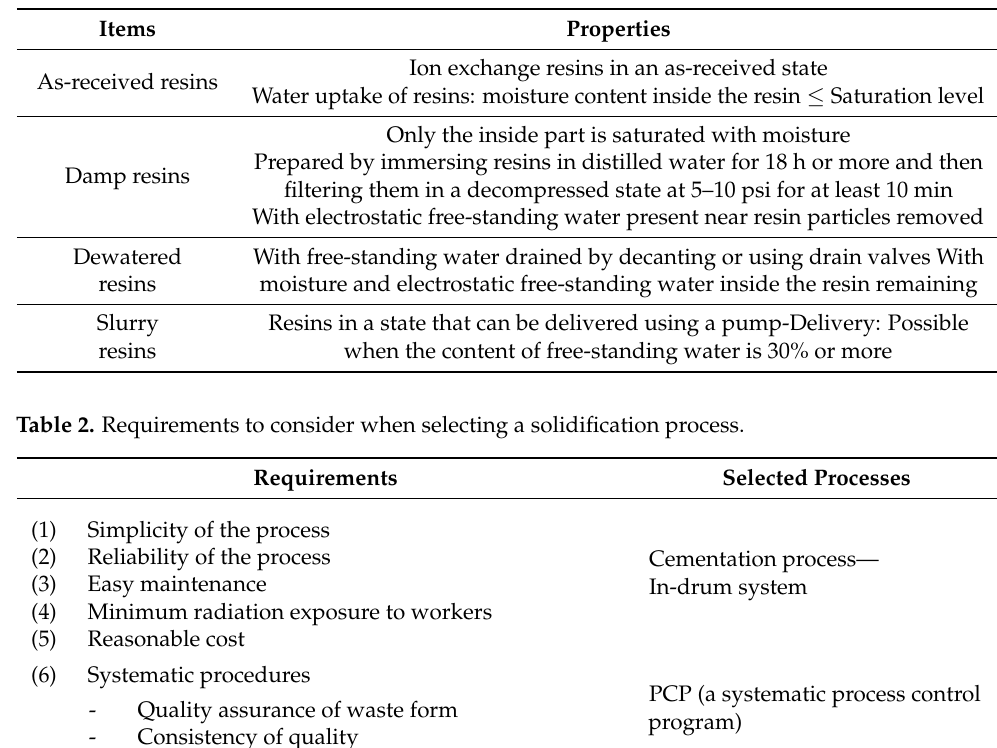
Table 1. Classification of ion-exchange resins according to the moisture content.